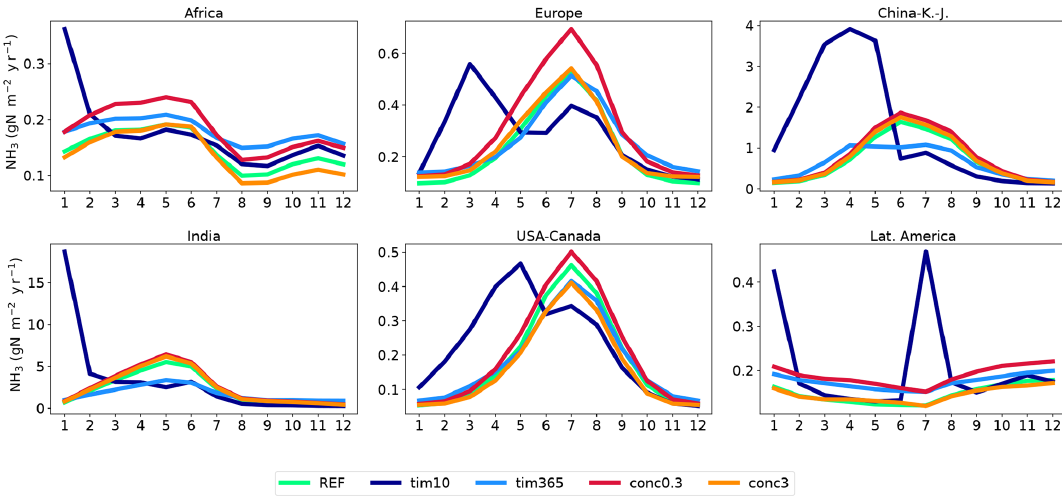
Figure 9. Regional NH 3 emissions (gNm − 2 yr − 1 ) from different sets of simulations. Green lines are the emissions from the reference CAMEO simulations. Dark and light blue lines are emissions from the respective TIM 10 and TIM 365 simulations. Dark red and orange lines are emissions from the respective CONC 0 . 3 and CONC 3 simulations. China–K–J accounts for China, Korea, and Japan.